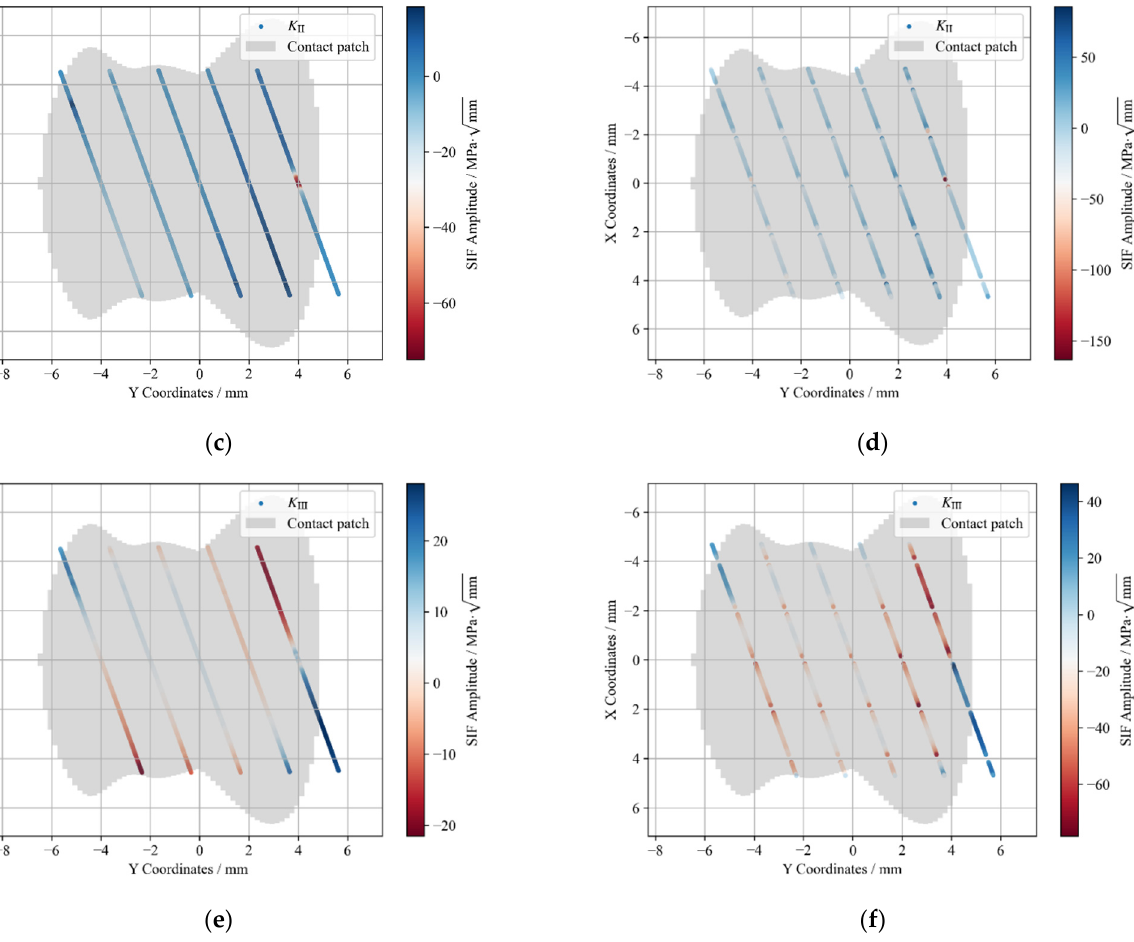
Figure 12. Results of SIFs at the transition curve: ( a ) SIF of type I cracks without the grinding marks; ( b ) SIF of type I cracks with the grinding marks; ( c ) SIF of type II cracks without the grinding marks; ( d ) SIF of type II cracks with the grinding marks; ( e ) SIF of type III cracks without the grinding marks; ( f ) SIF of type III cracks with the grinding marks.